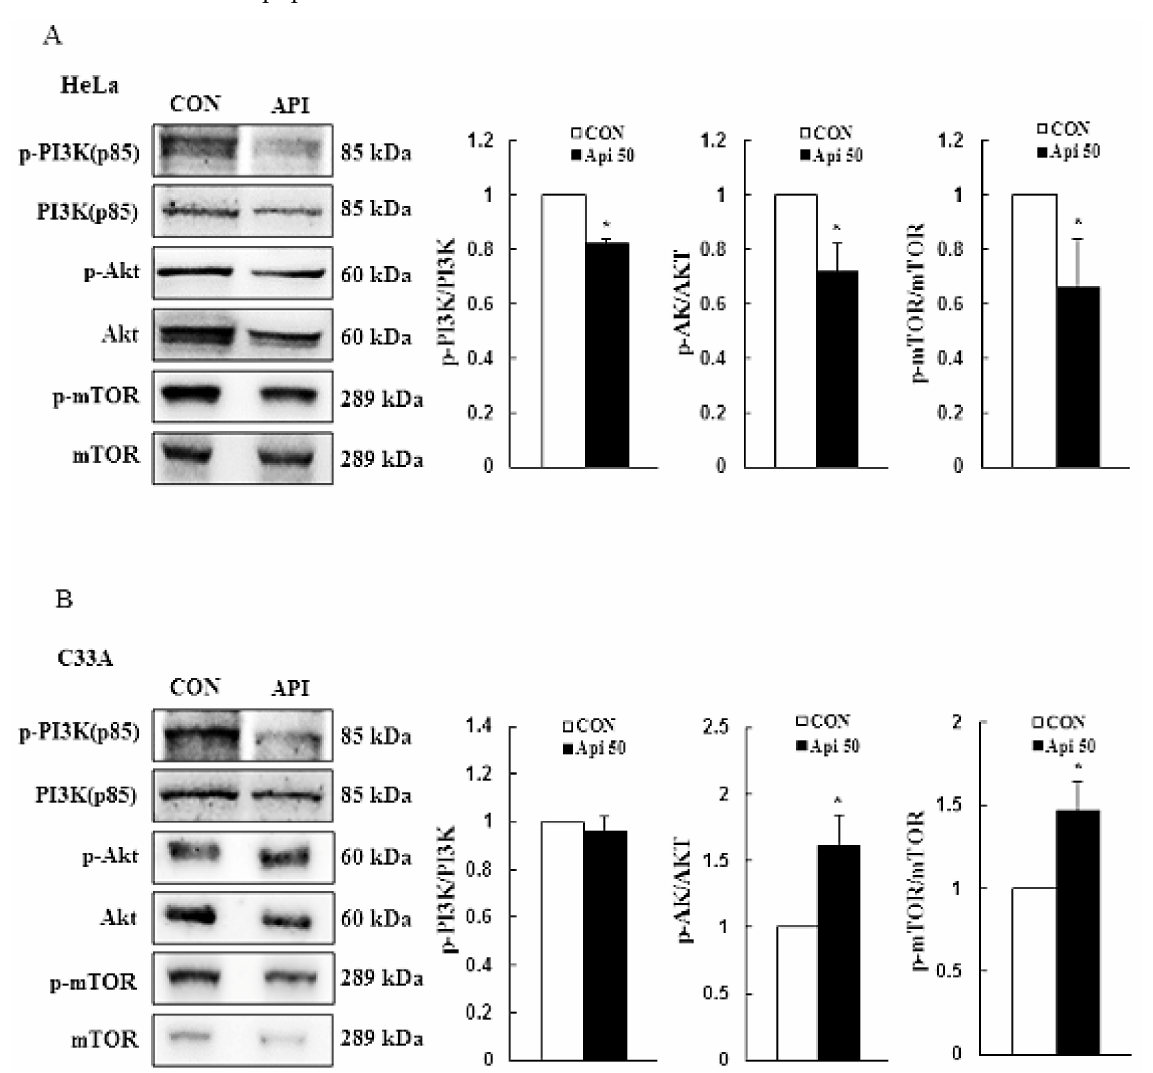
Figure 3. Effects of apigenin on the PI3K/AKT/mTOR signaling pathway in cervical cancer cells. Proteins p-PI3K (p85), PI3K (p85), p-AKT, AKT, p-mTOR, and mTOR were detected in HeLa ( A )